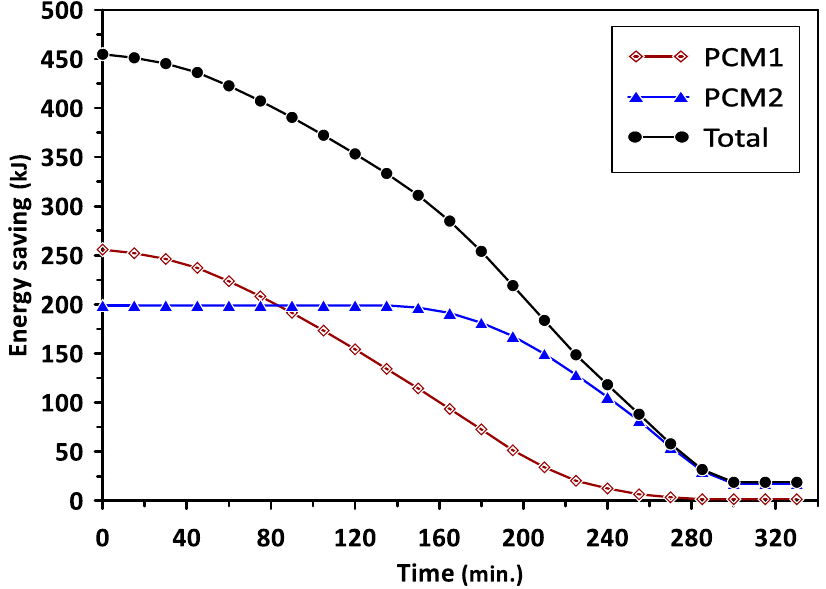
Figure 11. Energy saving of PCM1 and PCM2 during the discharging cycle.